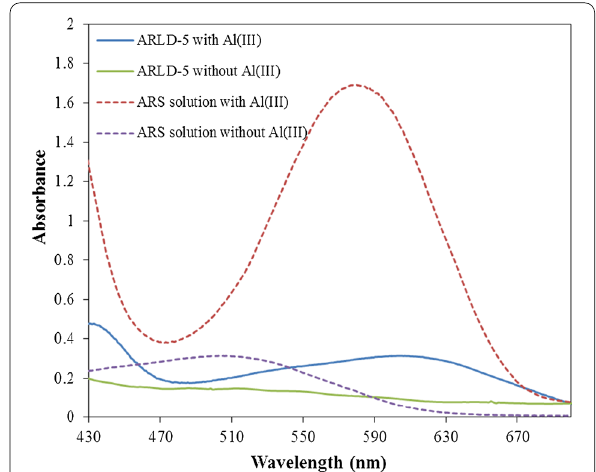
Fig. 12 The UV–Vis spectrophotometry test of ARS solutions (10 –4 M)